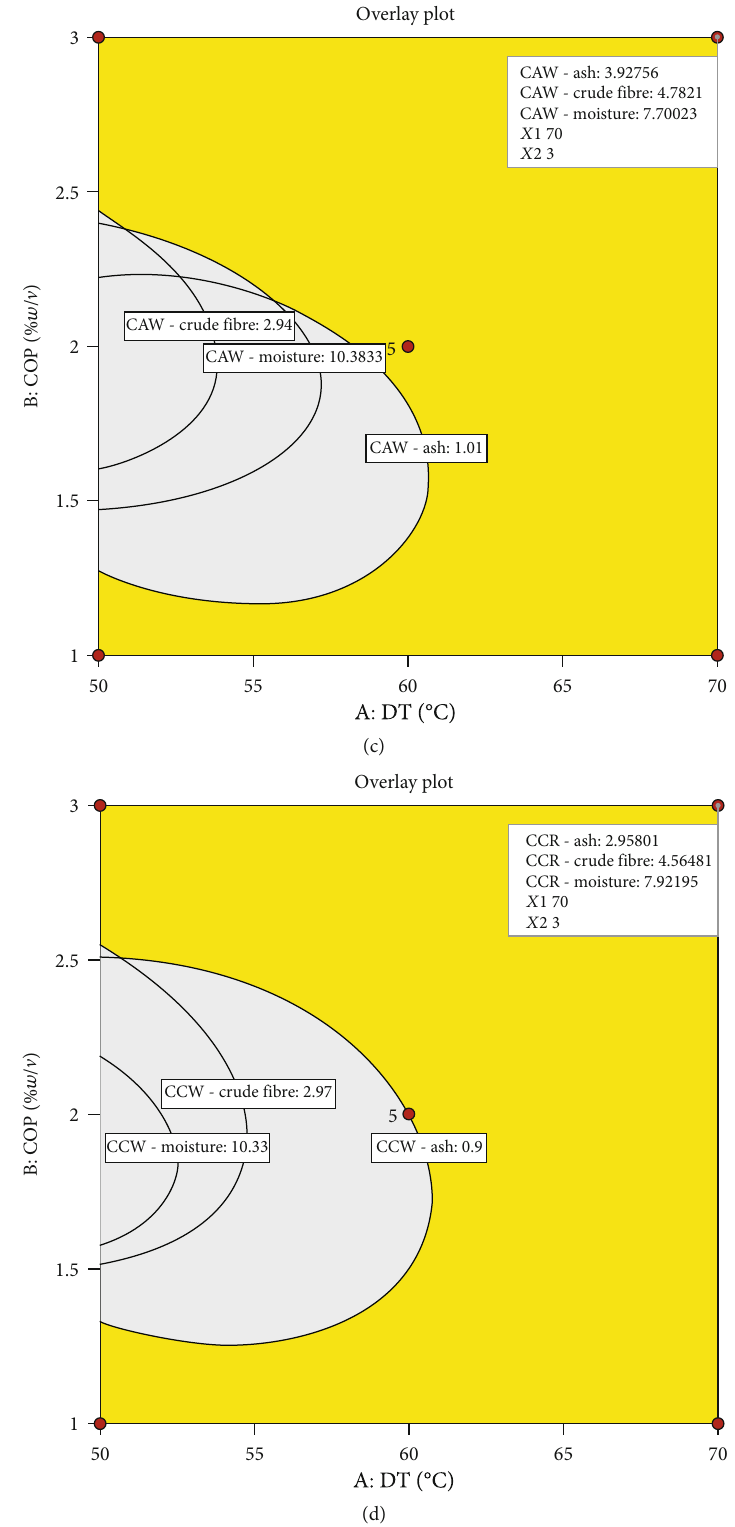
Figure 6: Multiresponse optimisation overlay plots of processing conditions and proximate components of cassava fl our. (a) Cassava from red landrace pretreated with citric acid. (b) Cassava from red landrace pretreated with calcium chloride. (c) Cassava from white landrace pretreated with citric acid. (d) Cassava from white landrace pretreated with calcium chloride. DT — drying temperature ( ° C); COP — concentration of pretreatment (% w / v